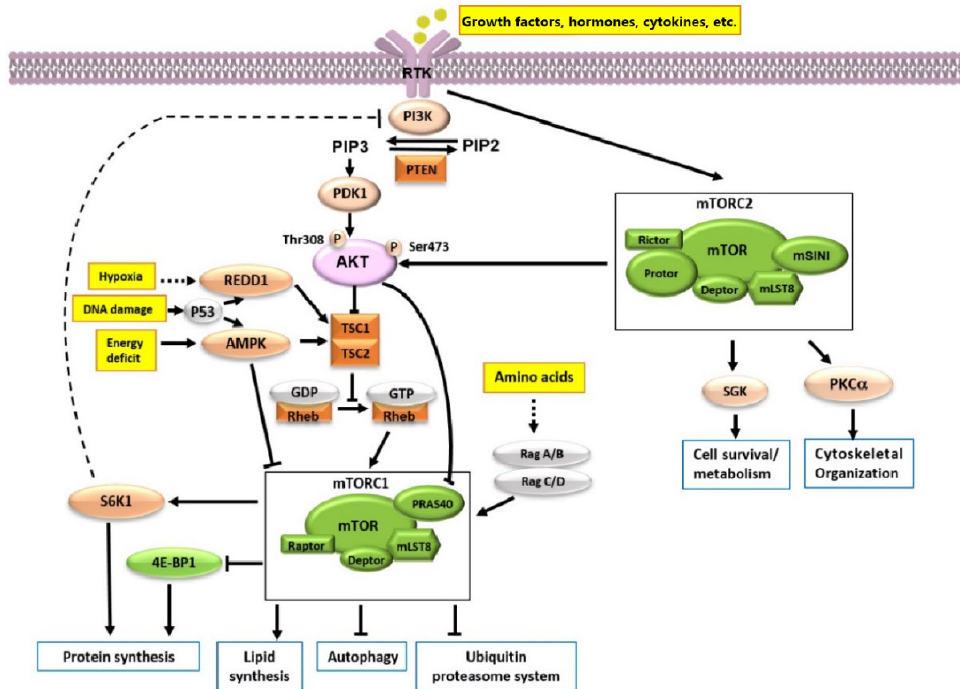
Figure 2. mTOR signaling pathways. mTORC1 responds to extracellular growth factors, stress, oxygen, and amino acids. Growth factors, hormones, cytokines, etc., activate PI3K, activated PI3K phosphorylates PIP2 to form PIP3, then AKT is phosphorylated and activated. AKT activates mTORC1 by inhibiting the interaction between TSC-1 and TSC-2. Low energy, hypoxia, and DNA damage can inhibit the activity of mTORC1 by activating REDD1 or AMPK, and inhibiting Rheb. The activation of mTORC1 by amino acids mainly occurs because Rag dimers are activated to form RagA/B and RagC/D. The signals downstream of mTORC1 activation mainly involve S6K1 and 4E-BP1, which affect synthesis of proteins and lipids. mTORC1 also affects autophagy and ubiquitin proteasome system. Signals downstream of mTORC2 regulate AKT, SGK1 and PKC, which regulate cell metabolism, survival and cytoskeletal organization.